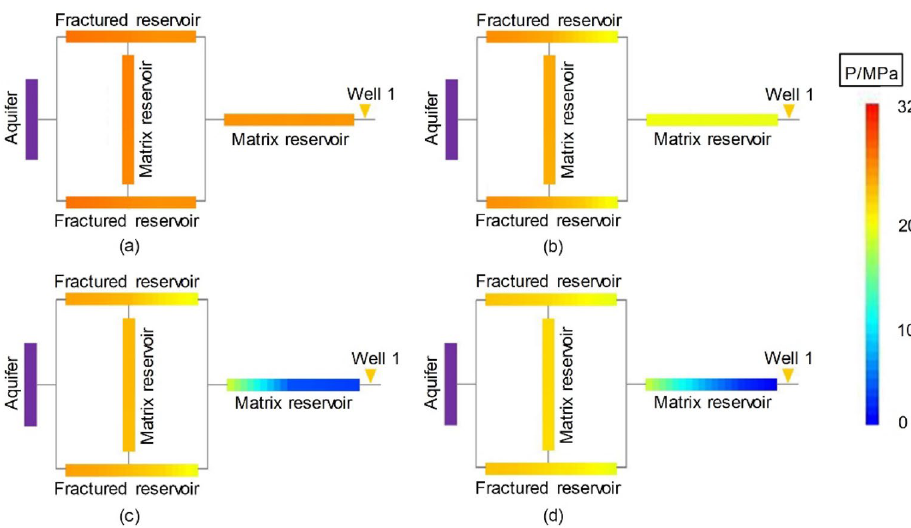
Figure 8. Pressure distributions at different stages of Experiment 1-1: ( a ) early stage of production—10 min, ( b ) early stage of production—20 min, ( c ) end of the stabilized period—30 min, and ( d ) production halts -76